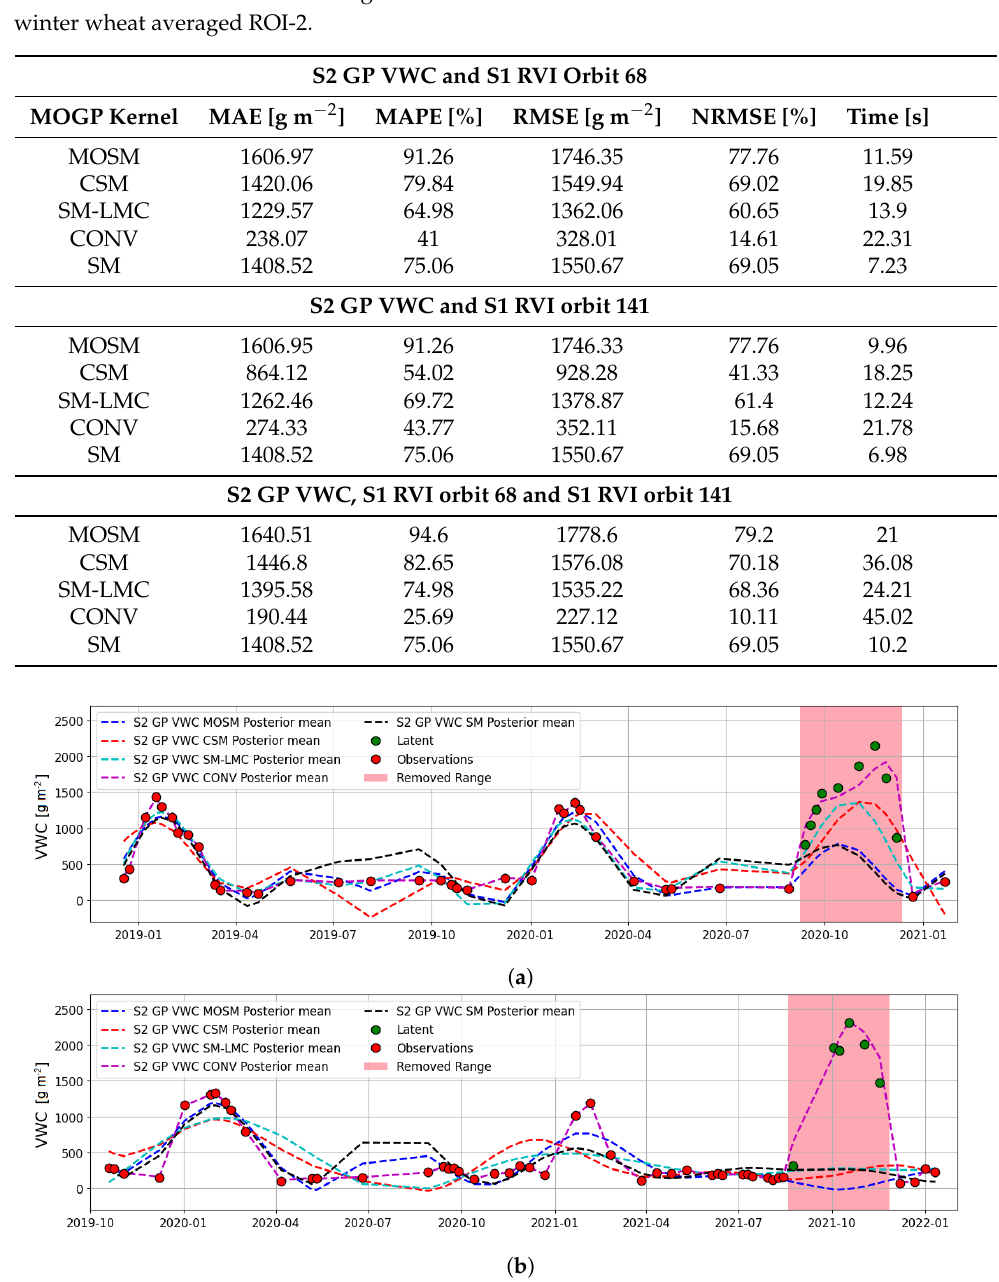
Figure 5. Performance of the SOGP and MOGP models predictions for VWC data reconstruction based on the S1 & S2 synergy. The green dots represent the latent S2 GP VWC data used to compute the error metrics whereas the red dots correspond to the S2 GP VWC cloud-free observations utilized to train the regression models. The red-shaded area represents the artificially created S2 data gap. SOGP and MOGP predictions performance for the selected winter wheat ROI-1 of the year 2020 ( a ) and 2021 ( b